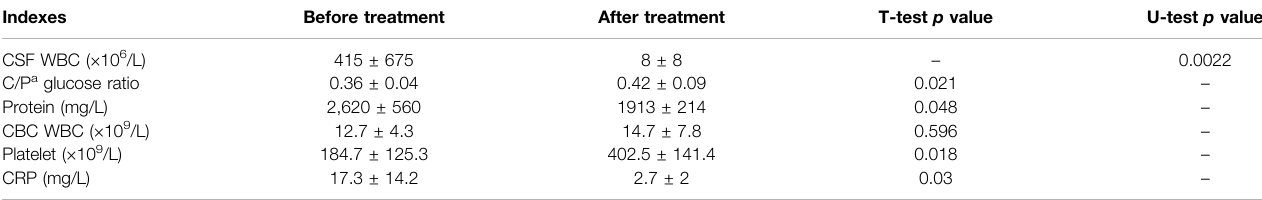
TABLE 3 | Comparison of ef fi cacy indexes before and after voriconazole treatment. Indexes